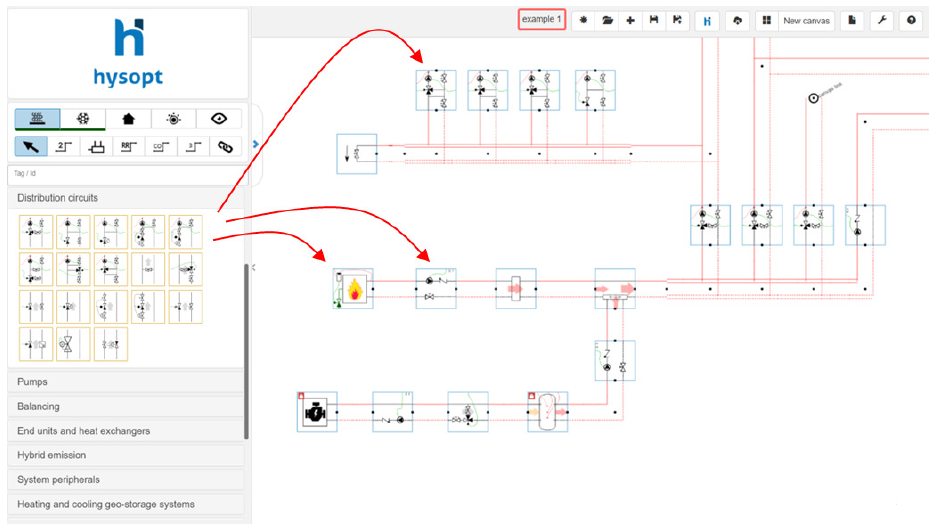
Fig. 21. – Impression from the Hysopt